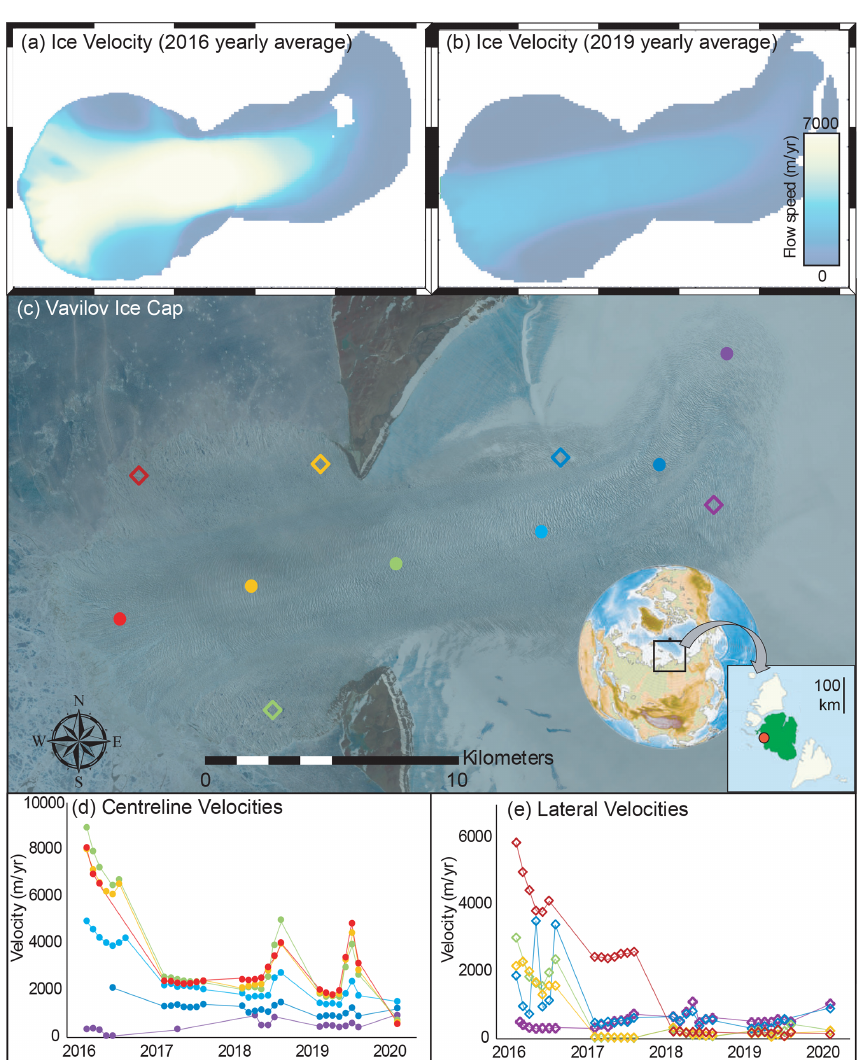
Figure 8. (a, b) 100m resolution annual mean velocities for the western outlet glacier of Vavilov Ice Cap. (c) A 2019 Sentinel-2 image showing the main features of this outlet and the locations used to derive monthly time series. (d, e) Monthly resolution velocity time series along the glacier centreline and flanks using Sentinel-2